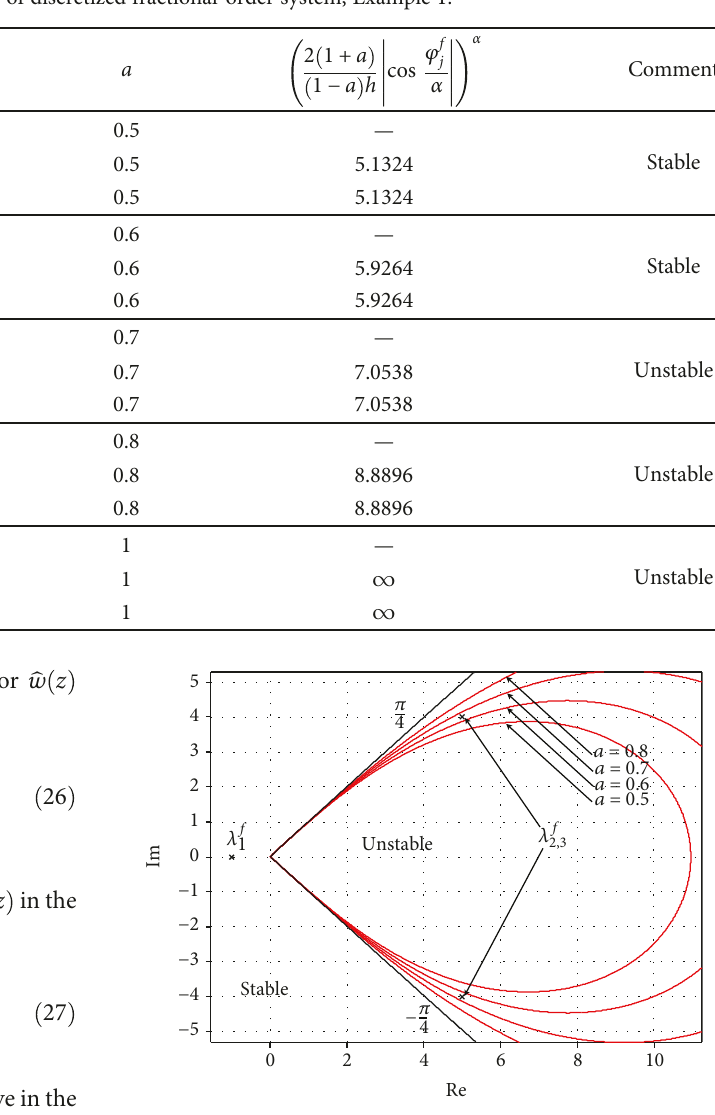
Figure 5: Stability/instability areas for various a ; Example